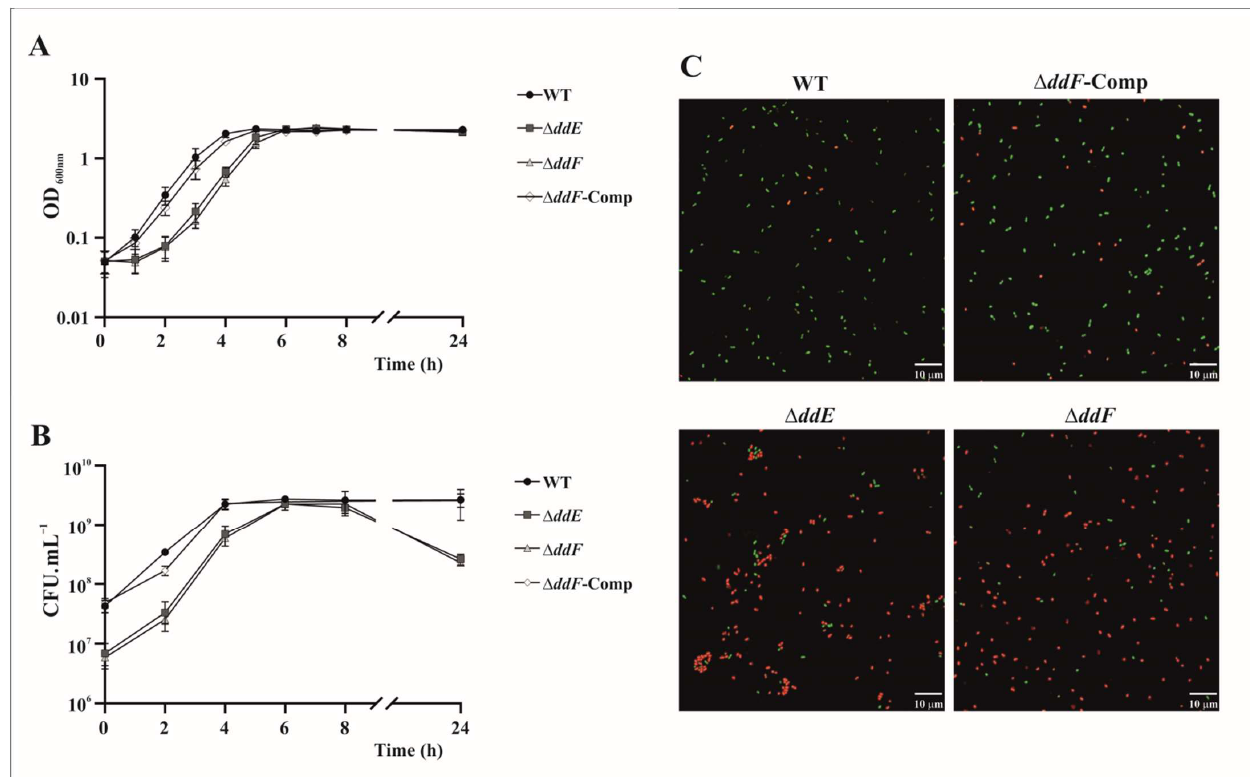
Figure 5. Analysis of bacterial growth of E. faecalis 14 strains by measuring the optical density at 600 nm ( A ) and by counting the colony-forming units per mL ( B ). ( C ) Confocal microscope images of bacteria stained with LIVE/DEAD viability kit at 24 h of bacterial growth.